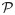
Visualization of performance measures.Two examples are shown. The original stimulus image is on the left with the subject’s fixation point marked. The middle image gives the ground truth mask where if the saliency algorithm produces a predicted P, our measure A will count a positive hit. The right image shows the extent of the human parafovea, the dashed circle, centered at subject’s fixation and superimposed on the GTM. Measure B will count a prediction as a hit if it falls within the marked area. Measure C and D will count a prediction as hit if measure B is a hit and the percentage of GTM area within the parafovea is sufficiently large. For these examples, 25% of the elk GTM area lies within the parafovea while the deer is 91% within. The elk image would lead to a ‘hit’ only for measures A and B whereas all the measures would count the deer as a hit.